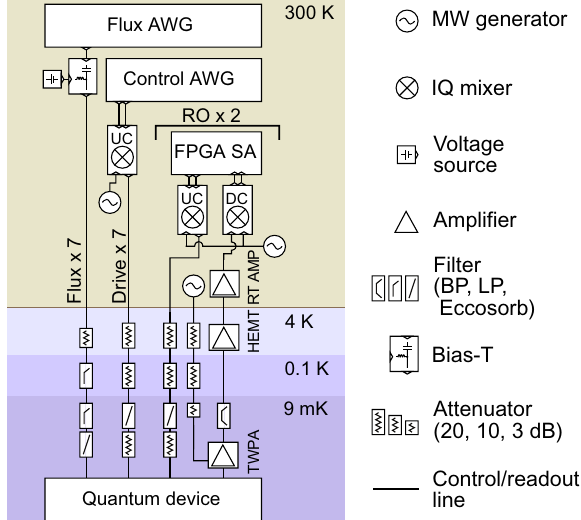
FIG. 6. Experimental setup. The experiment is controlled by AWGs whose signals are routed to the quantum device through a series of bandpass filters (BP), lowpass filters (LP), and Eccosorb filters. The flux pulses are combined with a voltage source using a bias-T. The IQ signal from the control AWG is up-converted (UC) to a microwave signal using an IQ mixer. The readout signal is generated by the FPGA SA, and the output from the quantum device is amplified by a chain of amplifiers before being down-converted (DC) and analyzed by the FPGA SA.